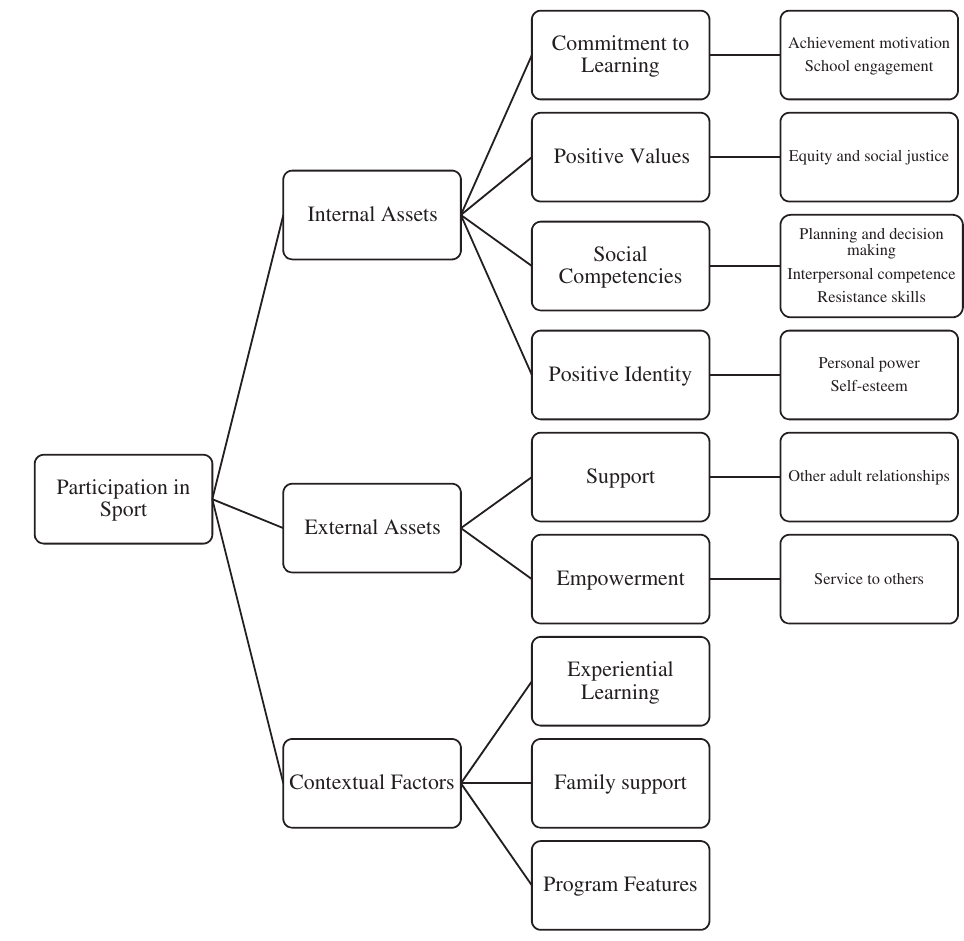
The educational and developmental benefits for Aboriginal youth sports participants. Interpersonal